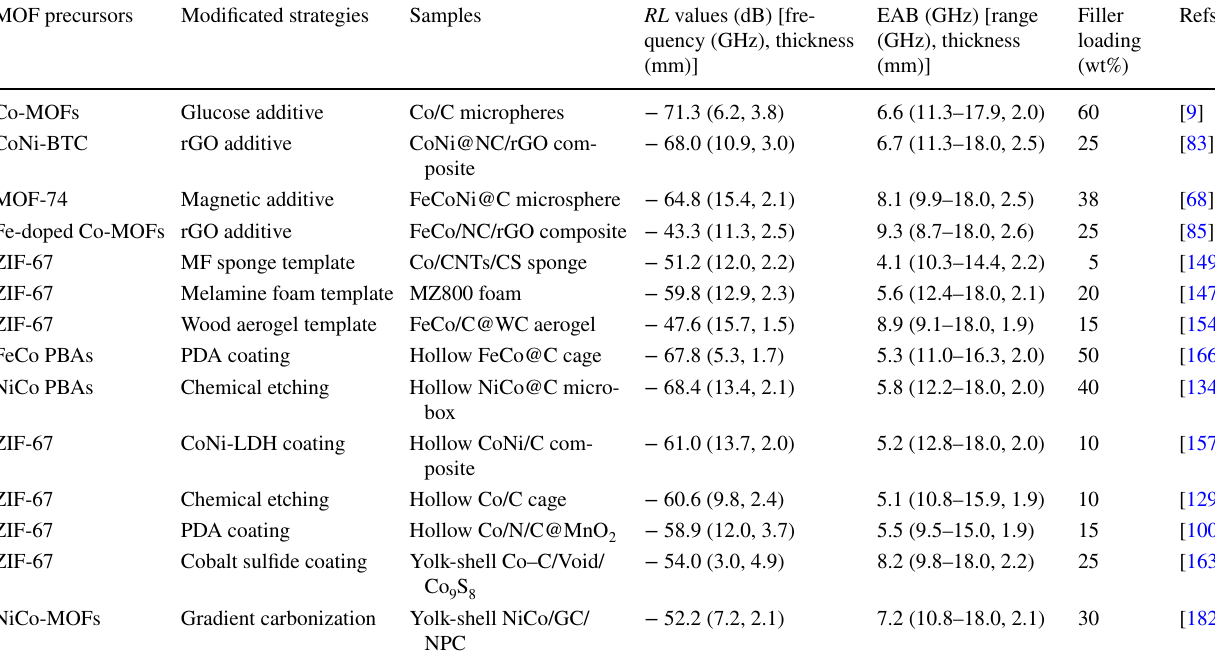
Table 1 EM absorption performance of some representative MOFs-derived magnetic carbon-based composites MOF precursors Modificated strategies